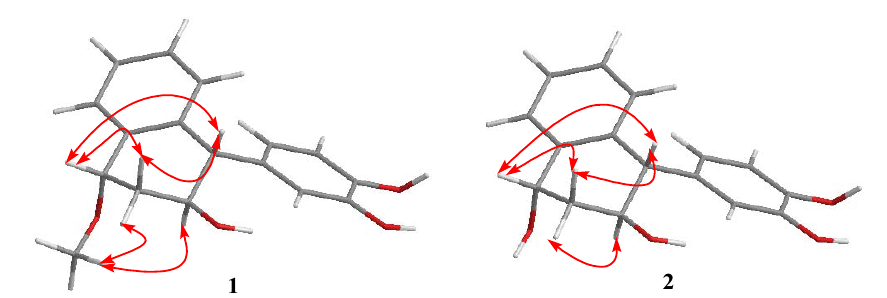
Figure 3. Selected ROESY correlations of 1 and 2